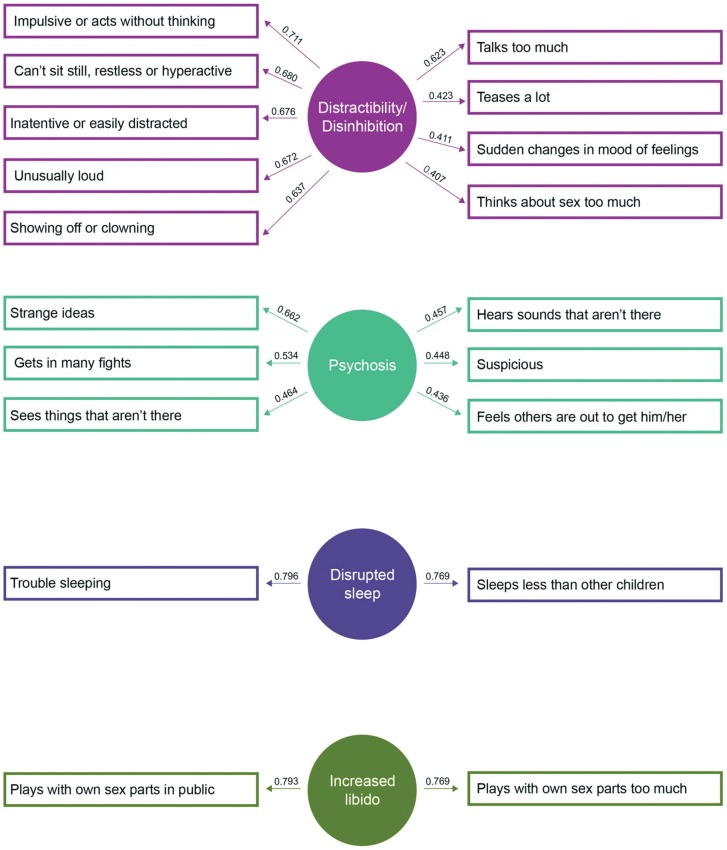
Factors and Factor Loadings of the Child Behavior Checklist-Mania Scale.